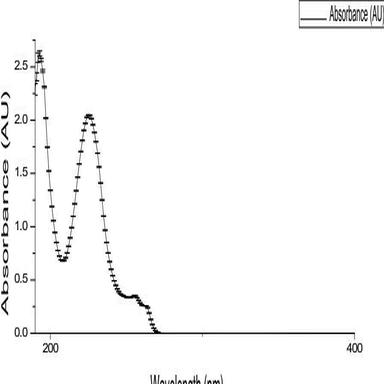
50 µM IC of DMPI & HP-b-CyD in water (Plot with standard deviation data).